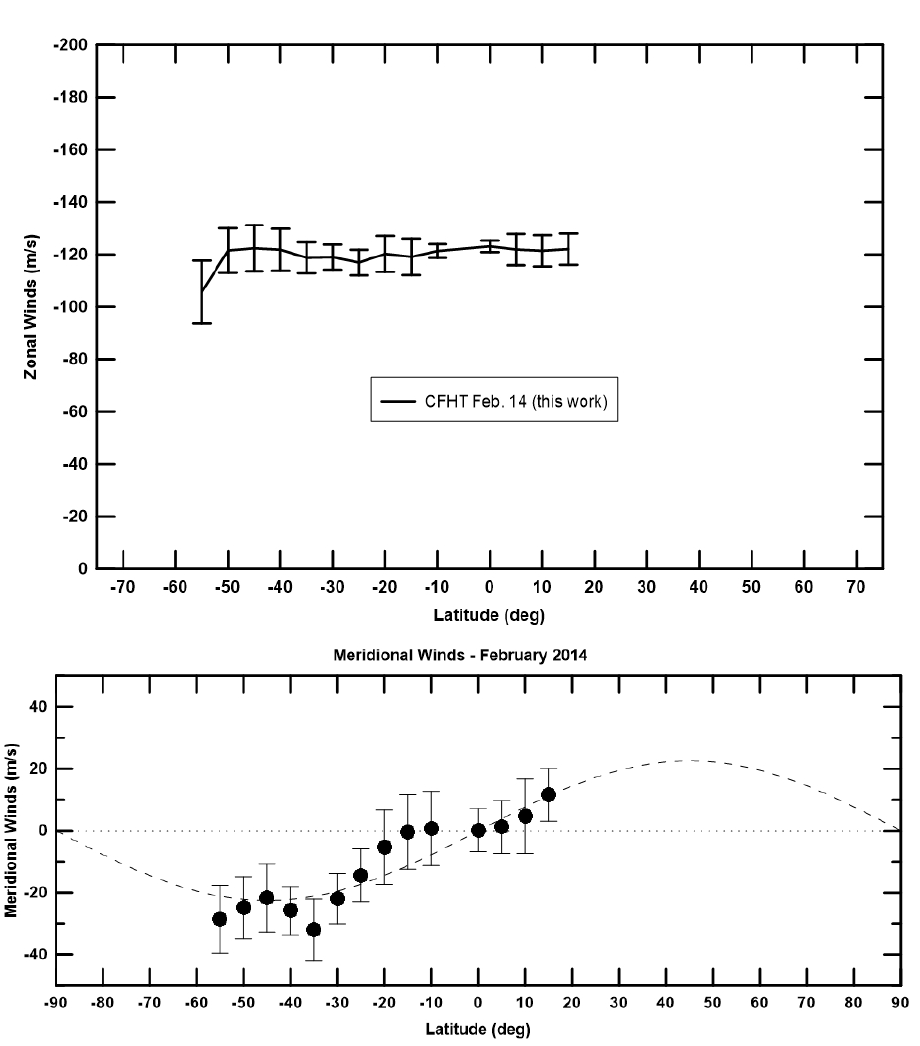
Figure 9. The upper panel and the lower panel present, respectively, the global mean zonal and meridional latitudinal wind profiles, regarding all three days of